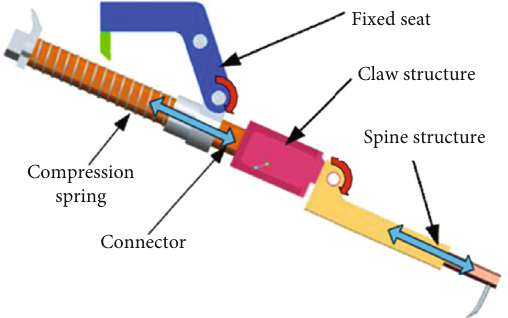
Figure 6: Composition of the spine anchoring system.